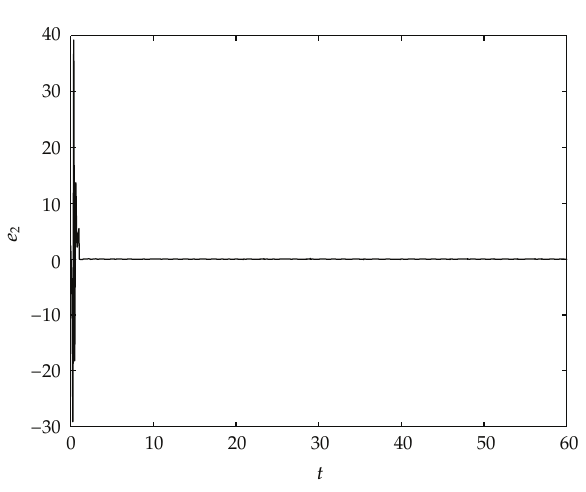
Figure 4: Synchronization error e 2 .